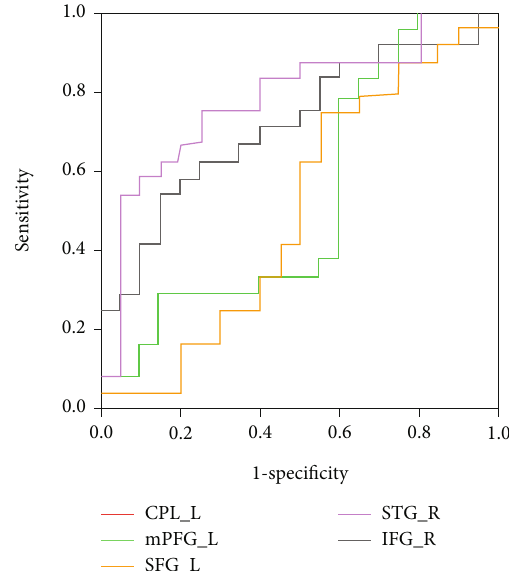
Figure 5: The receiver operating characteristic (ROC) curves for using GMV/fALFF values for the classi fi cation of PSND versus PSD patients. Speci fi cally, the AUC in the left cerebellum posterior lobe, left medial prefrontal cortex, left superior frontal gyrus, right superior temporal gyrus, and right inferior frontal gyrus are 0.804, 0.531, 0.502, 0.783, and 0.717, respectively. AUC: area under the curve; fALFF: fractional amplitude of low- frequency fl uctuation; CPL_L: left cerebellum posterior lobe; mPFC_L: left medial prefrontal cortex; SFG_L: left superior frontal gyrus; STG_R: right superior temporal gyrus; IFG_R: right inferior frontal gyrus.